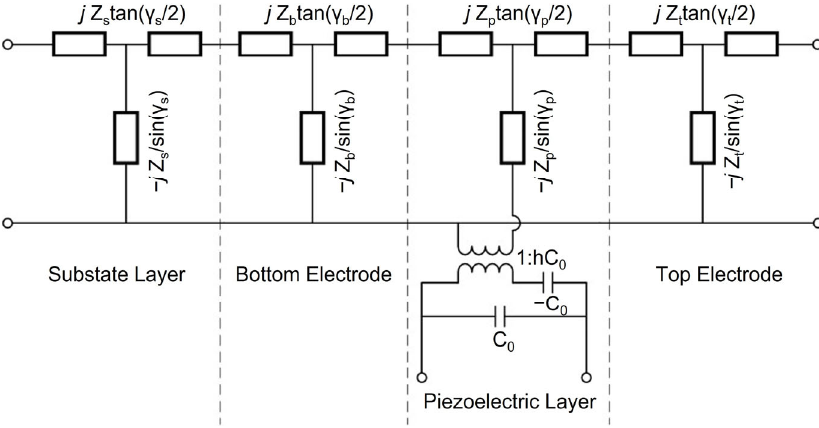
Figure 7. Equivalent circuit of the Mason model for Al 1 − x Sc x N HBAR device.